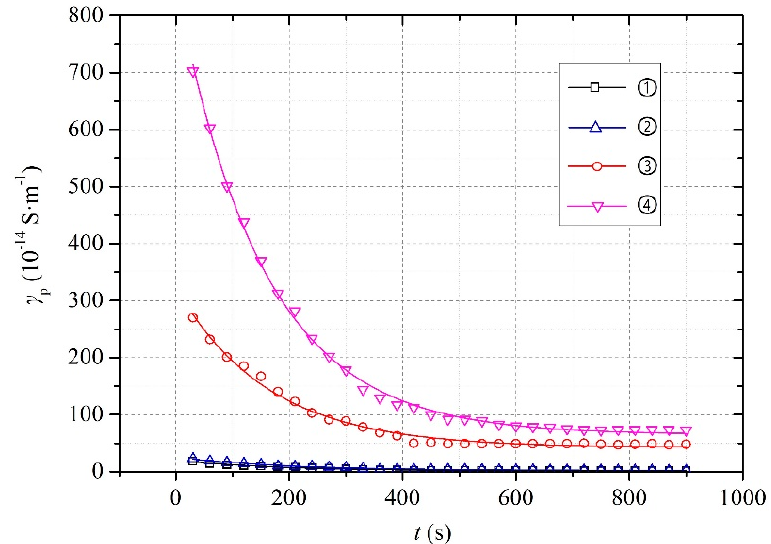
Figure 4. Relationship between pressboard conductivity and voltage applying time under different conditions: ○ 1 − 1 kV/mm, 25 °C, w = 0.9%; ○ 2 − 30 kV/mm, 25 °C, w = 0.9%; ○ 3 − 1 kV/mm, 100 °C, w = 0.9%; ○ 4 − 1 kV/mm, 25 °C, w = 2.8%.